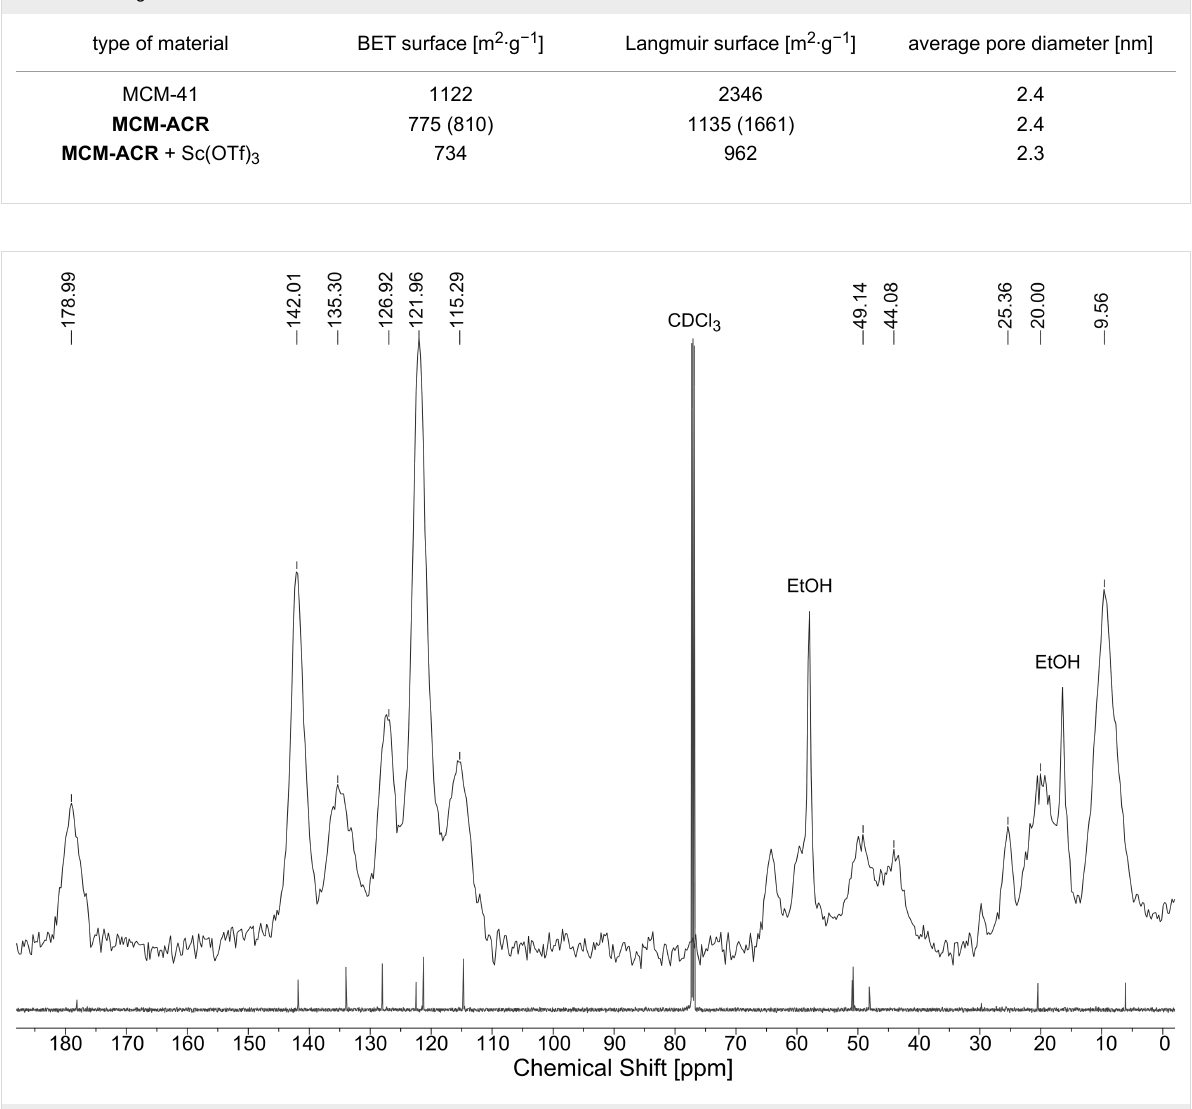
Figure 6: 13 C CP-MAS NMR spectrum of MCM-ACR overlaid with the high resolution 13 C NMR spectrum of precursor 1 (recorded in CDCl 3